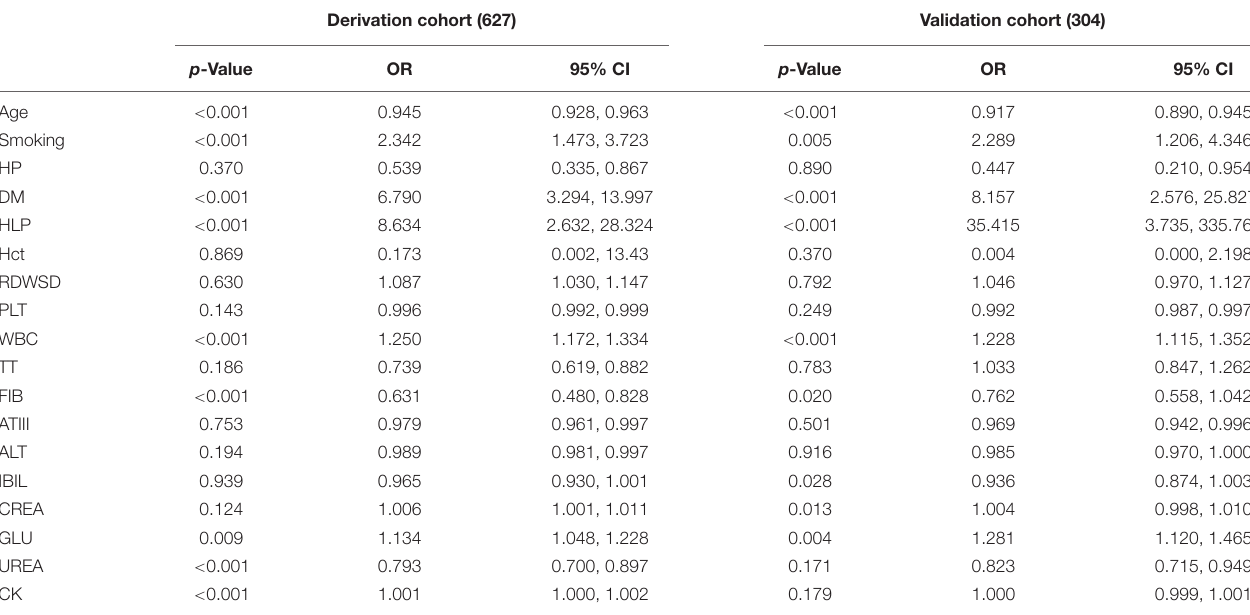
TABLE 2 | Indicators in the Stroke Diagnosis Aid